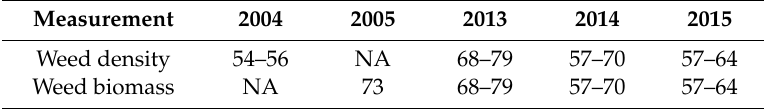
Table 3. Overview of the timing in days after sowing of measurements taken in the trial. Measurement 2004 2005 Weed density